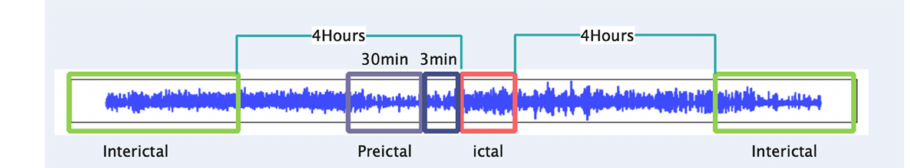
Figure 3. Division of EEG signals in the different stages of epilepsy.